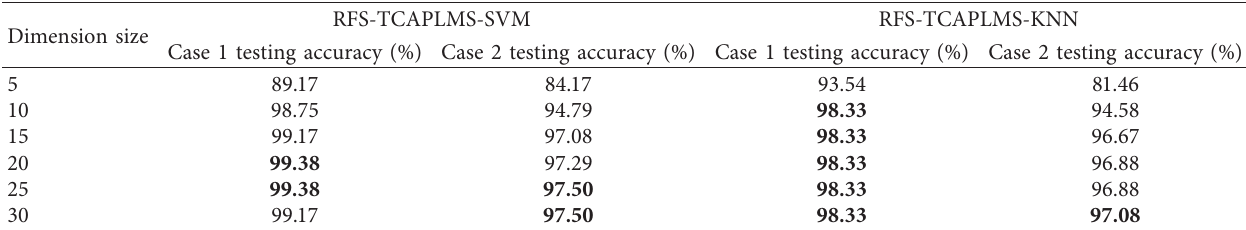
Table 8: Testing accuracies of RFS-TCAPLMS-SVM and RFS-TCAPLMS-KNN. Dimension